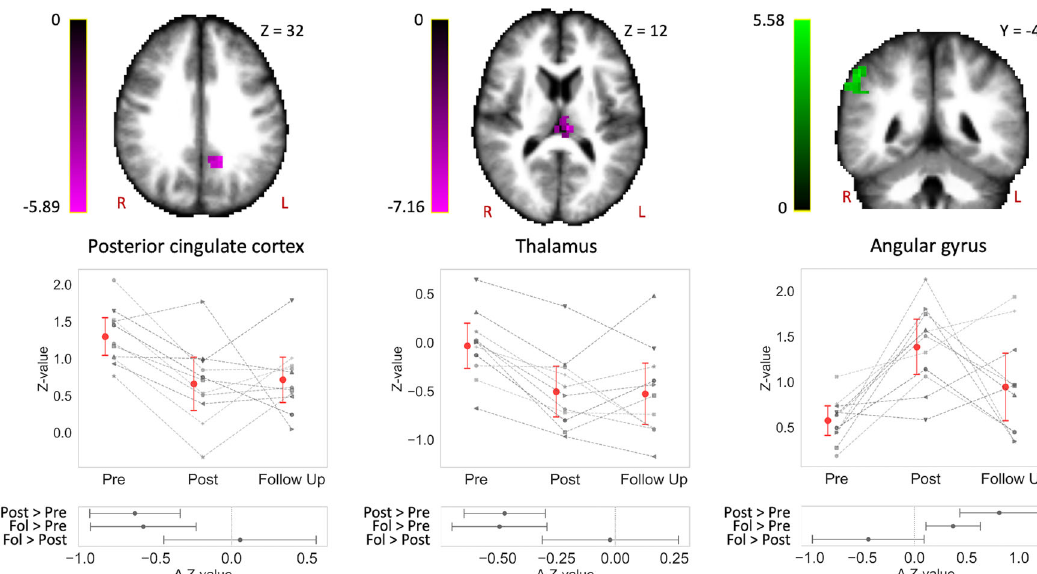
Fig. 2 Connectivity in posterior cingulate cortex, thalamus, and right angular gyrus is changed after space fl ight and sustains in the longer term. The posterior cingulate cortex and the thalamus showed decreased participation in whole-brain connectivity (magenta), while the right angular gyrus exhibited increased participation in whole-brain connectivity (green) at post fl ight compared to pre fl ight. These effects were found to persist up to 8 months after the space mission (Fol for follow-up). Signi fi cant clusters are scaled by t -statistic and slice coordinates are represented in MNI space. The plots illustrate cosmonaut-speci fi c (gray) intrinsic connectivity contrast (ICC) changes in each signi fi cant cluster (red: mean). Subplots summarize the estimated differences between pairs of timepoints. Error bars indicate 95% con fi dence intervals. Statistical signi fi cance is based on p < 0.005 uncorrected at the voxel level followed by p < 0.05 corrected for family-wise error at the cluster level ( n = 11). R right, L left.